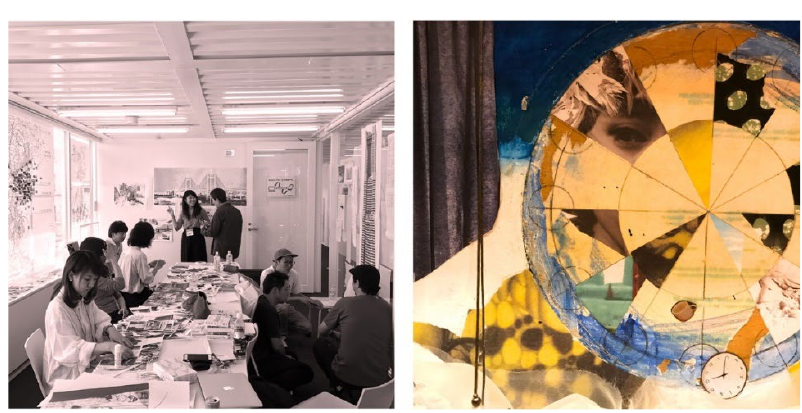
Figure 25 Workshop series “Look at the Crystal Ball!” and participants’ work .